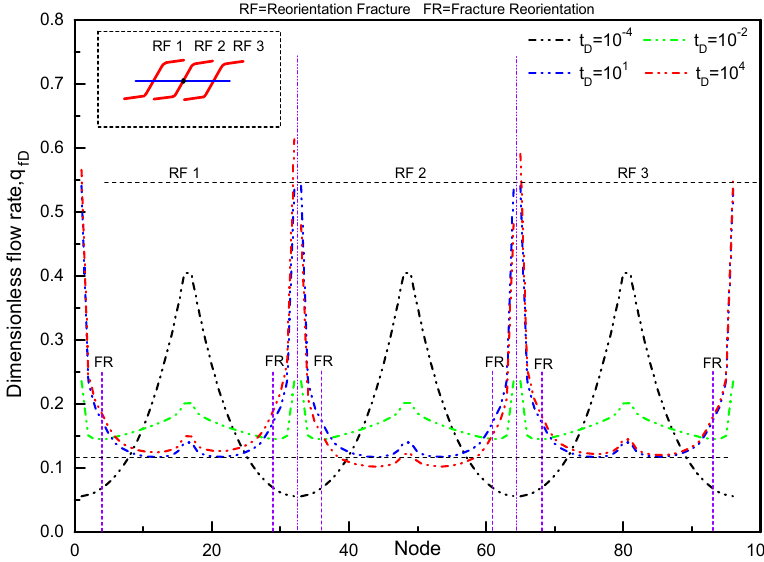
Figure 8. Rate distribution of a horizontal well with three reorientation fractures ( k x = k y ).